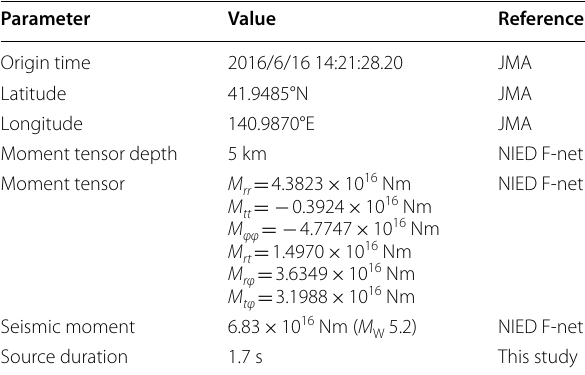
Table 3 Summary of source parameters in the ground motion